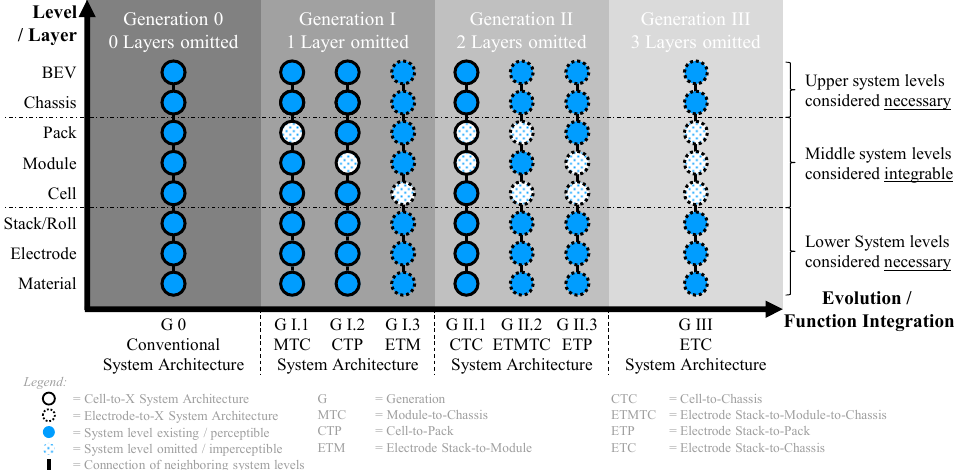
Figure 4. Di ff erentiation of architecture generations based on the number of omi tt ed system layers. Figure 4. Differentiation of architecture generations based on the number of omitted system